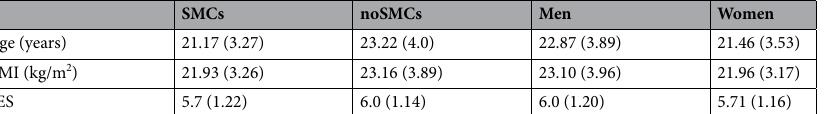
Table 1. Demographic data (mean and SD) for each group and sex. BMI body mass index, SES socioeconomic status, SMCs subjective memory